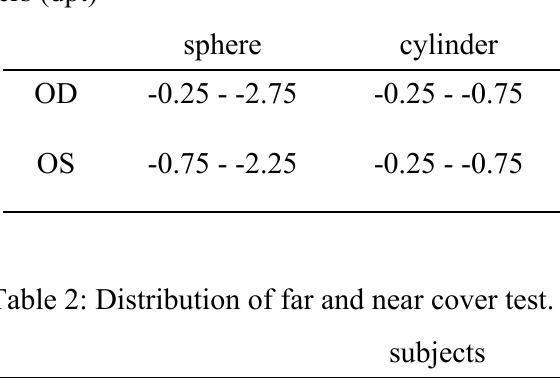
Table 1: Range of habitual corrections in diop-